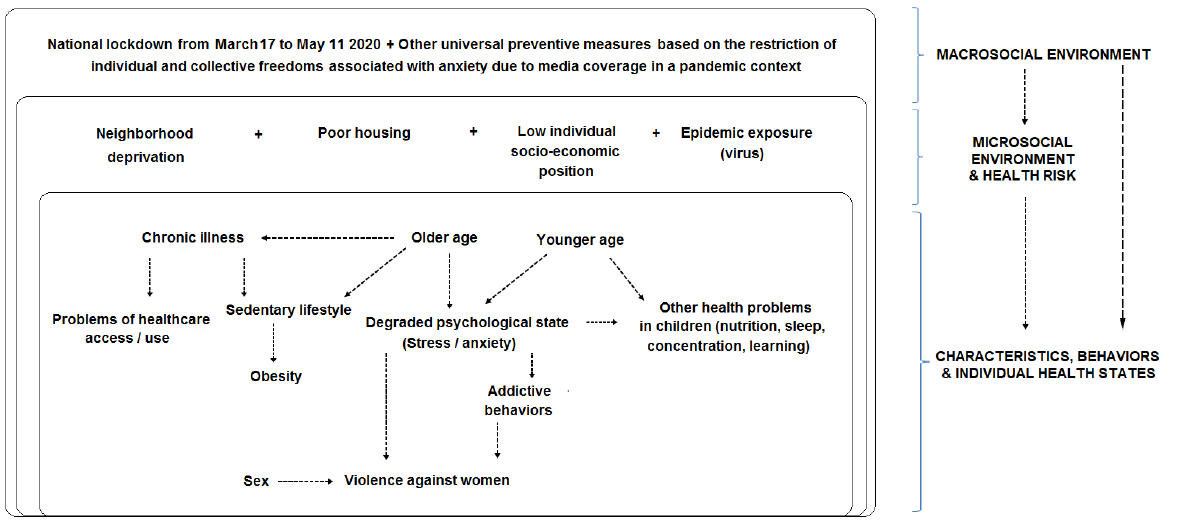
Figure 1. Conceptual model and socio-ecological framework.